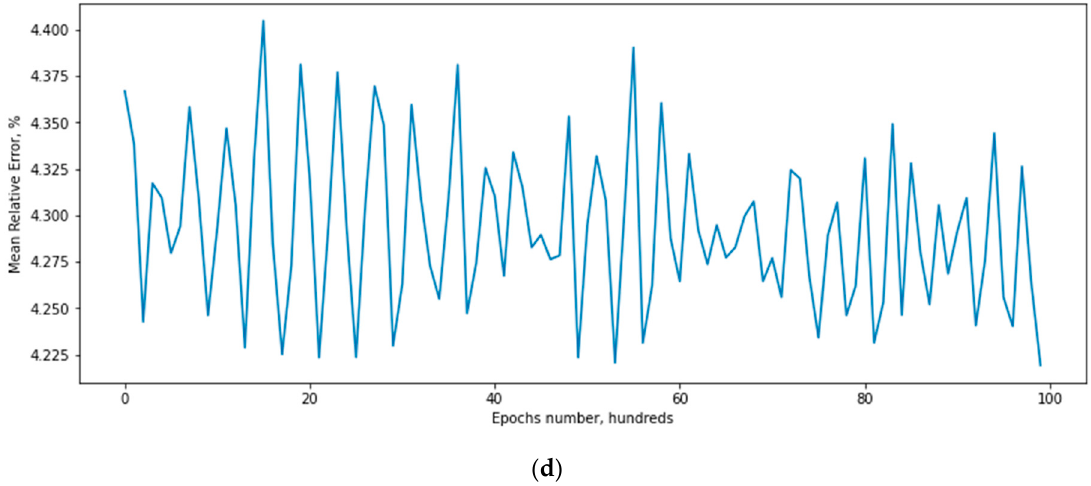
Figure 4. ( a ) MRE for ANN 1; ( b ) MRE for ANN 2; ( c ) MRE for ANN 3; ( d ) MRE for ANN 4.